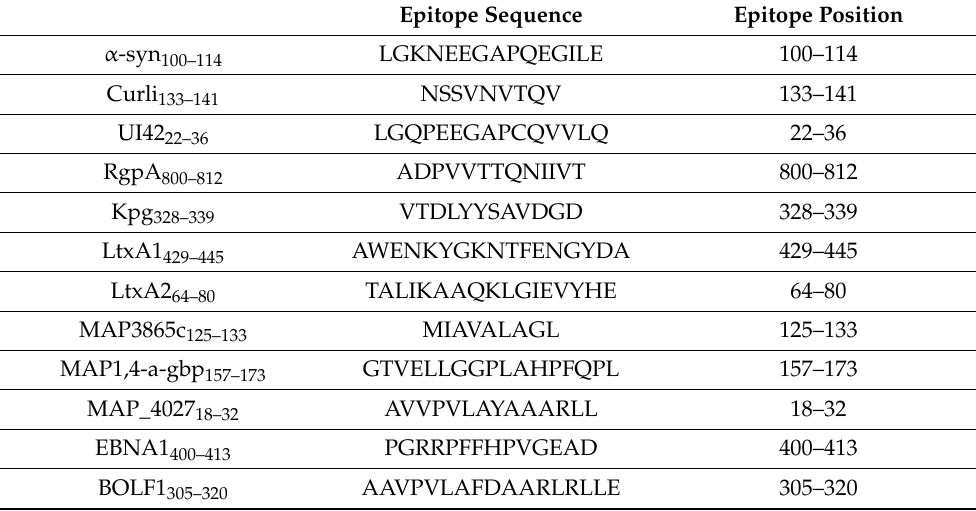
Table 1. Immunogenic peptides used as antigens in the ELISA